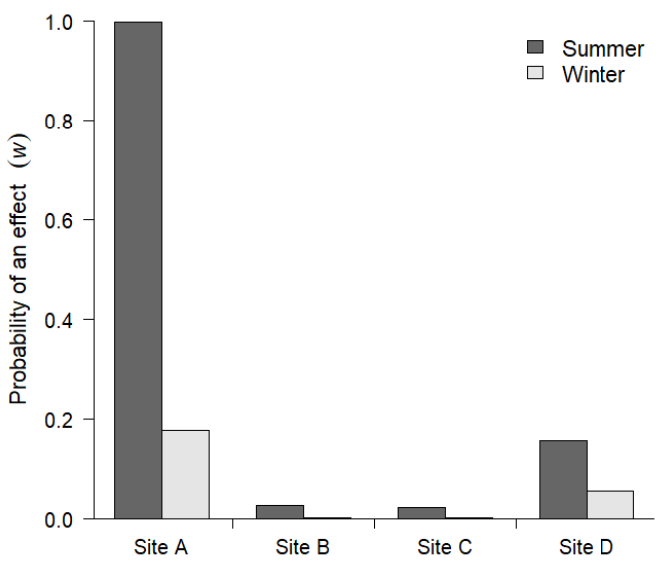
Figure 4. The probability that bait influenced second-order selection of male white-tailed deer ( Odo- coileus virginianus ) in southwestern Georgia, USA, during summer (2015) and winter (2016) camera surveys. camera